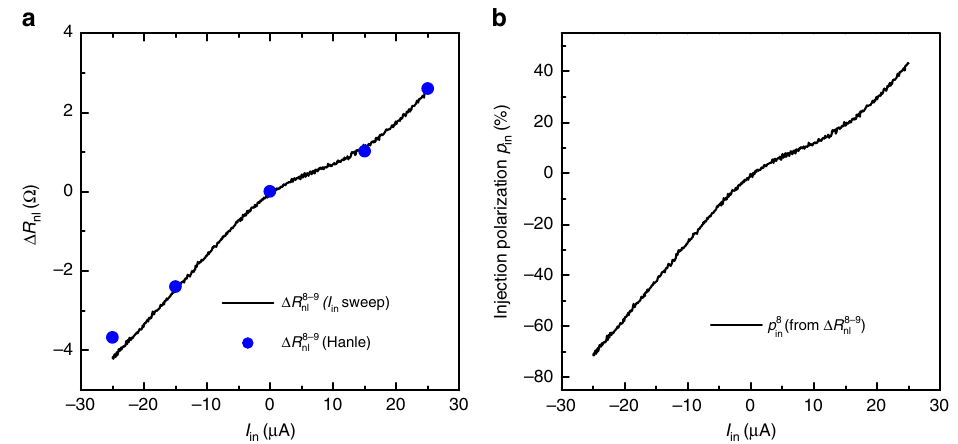
Fig. 3 Bias enhanced non-local differential spin signal and large differential spin-injection polarization at room temperature. a Non-local spin signal Δ R 8 (cid:2) 9 ( I in ) corresponding to the spin current injected through contact 8 and detected via contact 9, as a function of the DC current bias ( I in ) applied across nl the injector. The solid line represents the spin signal Δ R 8 (cid:2) 9 ( I in ) for a continuous sweeping of the I in bias, while the dots are extracted from the Hanle nl signals Δ R 8 (cid:2) 9 ( B z ) at B z = 0, measured at different bias (from Fig. 2b). b Differential spin-injection polarization of the injector contact 8, p 8 nl ( I in ) (Eq. (3)) data plotted in of I in , calculated from the Δ R 8 (cid:2) 9 nl